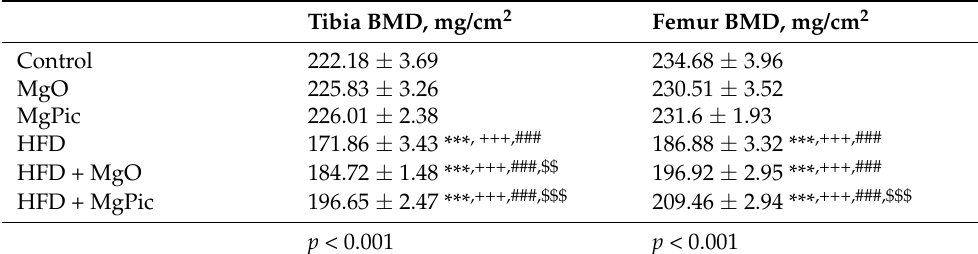
Table 3. Effect of MgO or MgPic supplementation on BMD in rats.